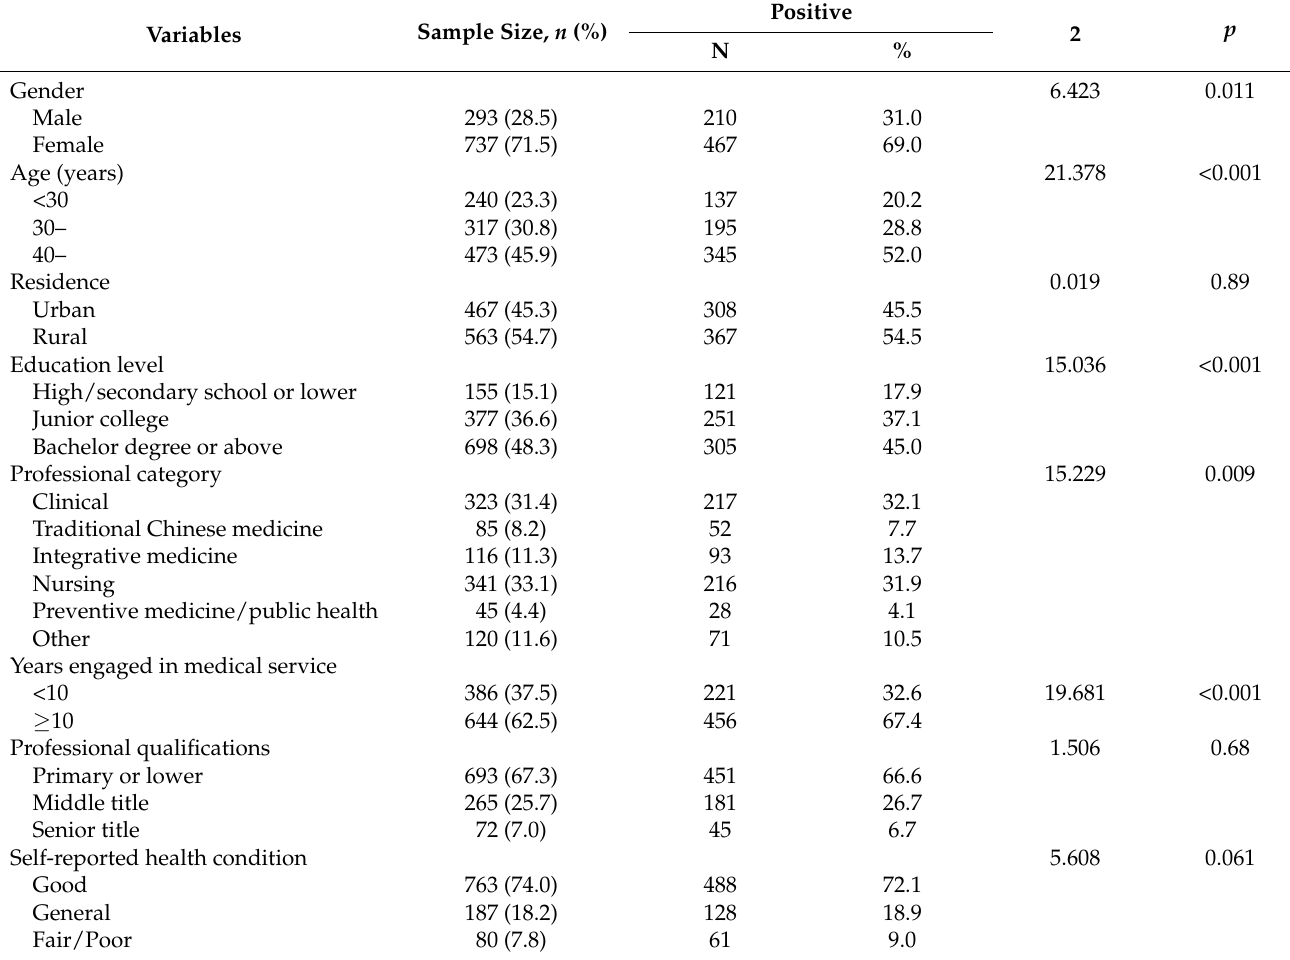
Table 1. Differences in influenza vaccine hesitancy between different demographic